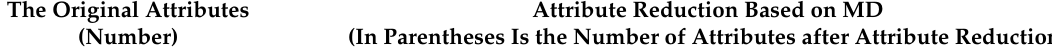
Table 3. Attribute reduction on each dataset based on different